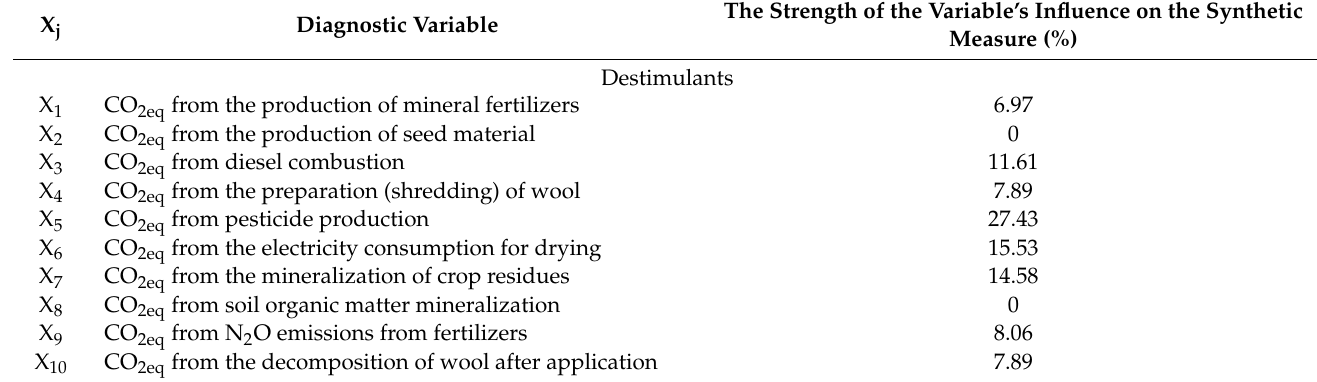
Table 9. Diagnostic variables adopted in the